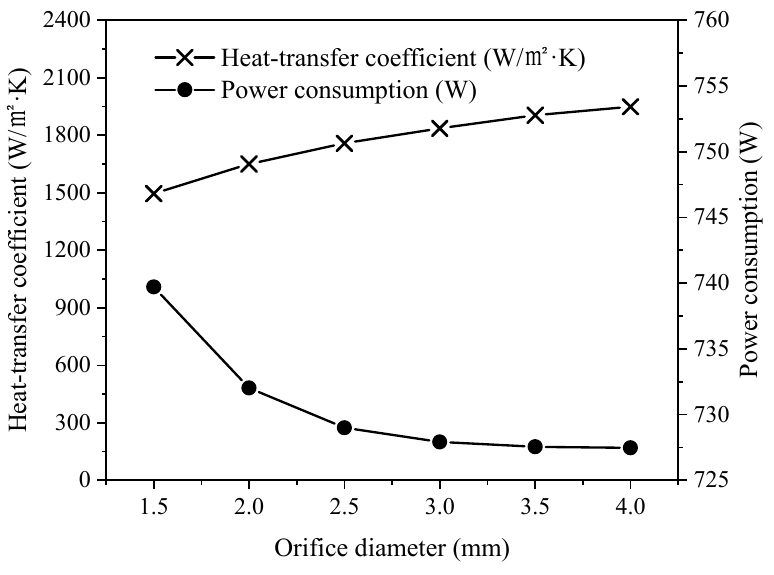
Figure 11. Heat-transfer coefficient and power consumption changes at different orifice diameters.